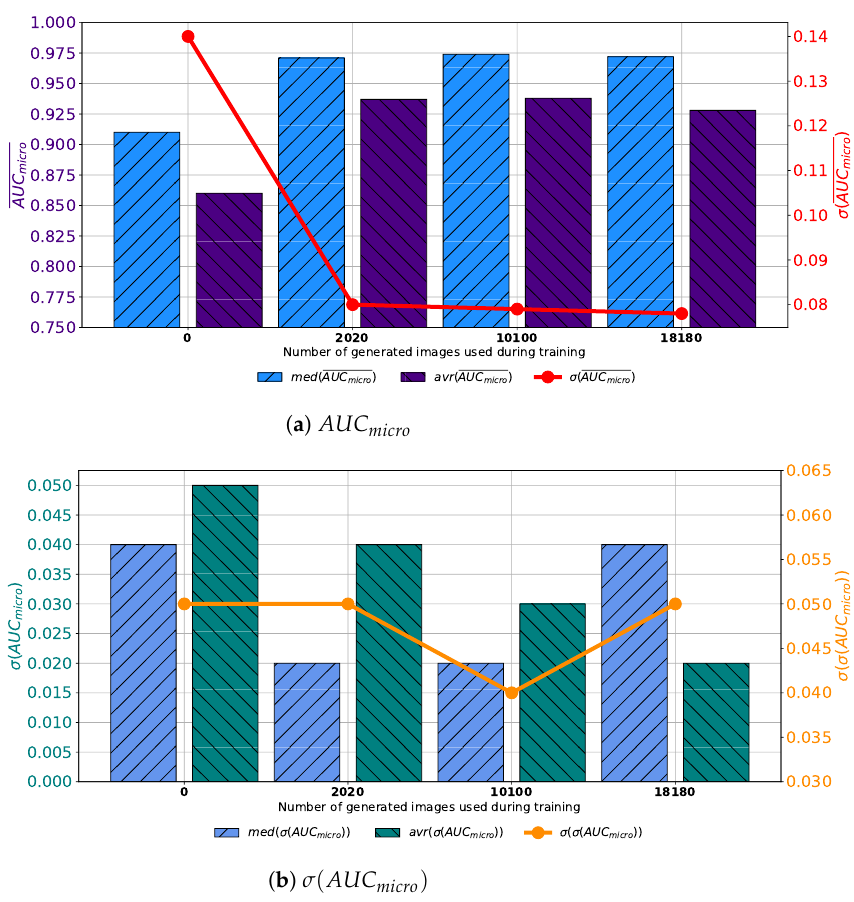
Figure 7. Median, average AUC micro and standard deviation of AUC micro and σ ( AUC micro ) for the case of AlexNet trained with images generated by GAN in 100